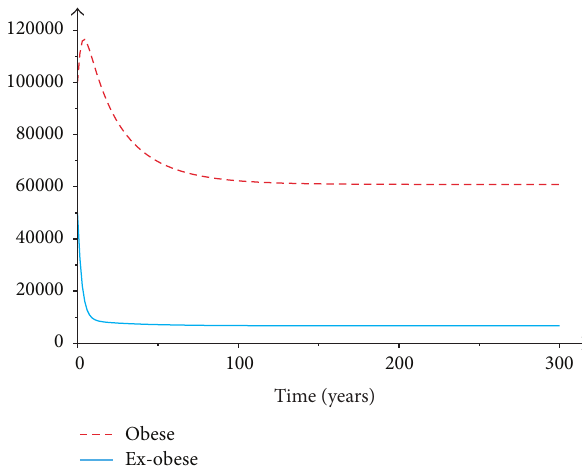
Figure 14: Infected (obese) and recovered (ex-obese) individuals as function of time. Here 𝜖 = 0 , 𝑅 0 = 1.2 , and the initial condition is (𝐼(0),𝑅(0)) = (100000, 80000) .